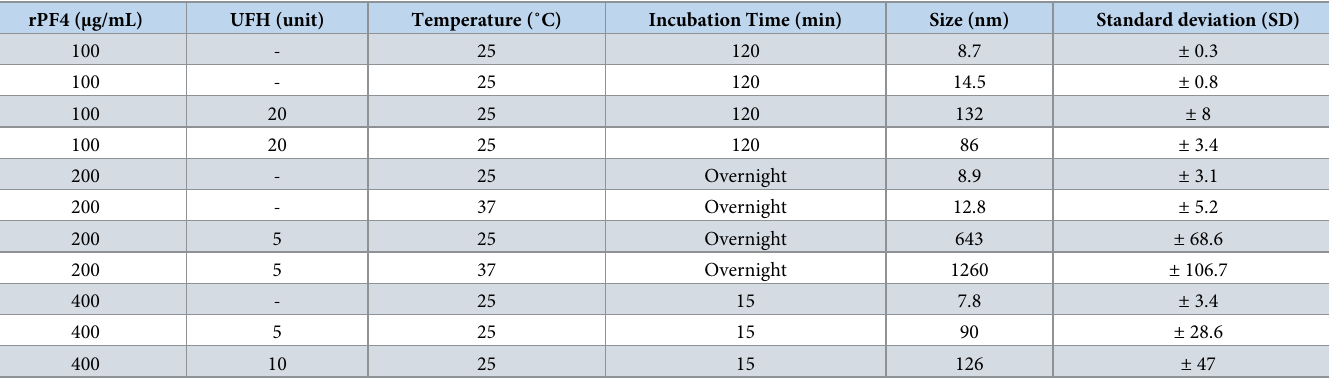
When purified rPF4 was subjected to DLS, the size of particles detected span a range of ~8–14 nm in size which indicates the formation of tetramers by the secreted rPF4. When the rPF4 was mixed with heparin, oligomeric structures ranging in size from ~90–1200 nm were detected indicating that the tetrameric rPF4 proteins acquired functional quaternary structures and were able to undergo oligomerization in the presence of the UHF. The size of the oligomeric structures is commensurate with an increase in incubation time and temperature up to 37˚C.